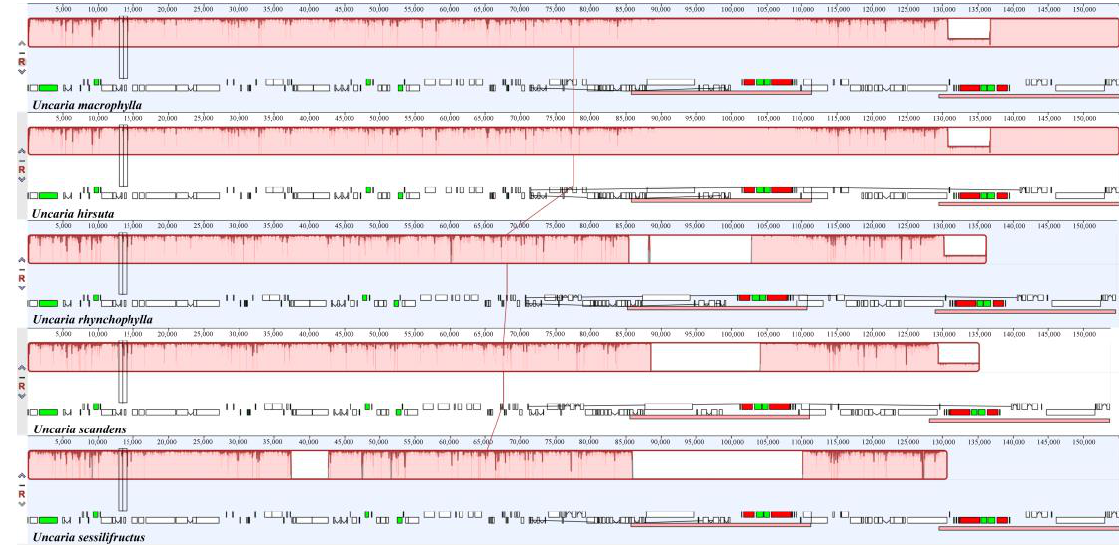
Figure 8. Comparison of LSC, IR, and SSC junction positions among five Uncaria species in cp ge- nomes. JLB denotes the LSC/IRb junction, JSB denotes the SSC/IRb junction, JSA denotes the SSC/IRa junction, and JLA denotes the LSC/IRa junction.